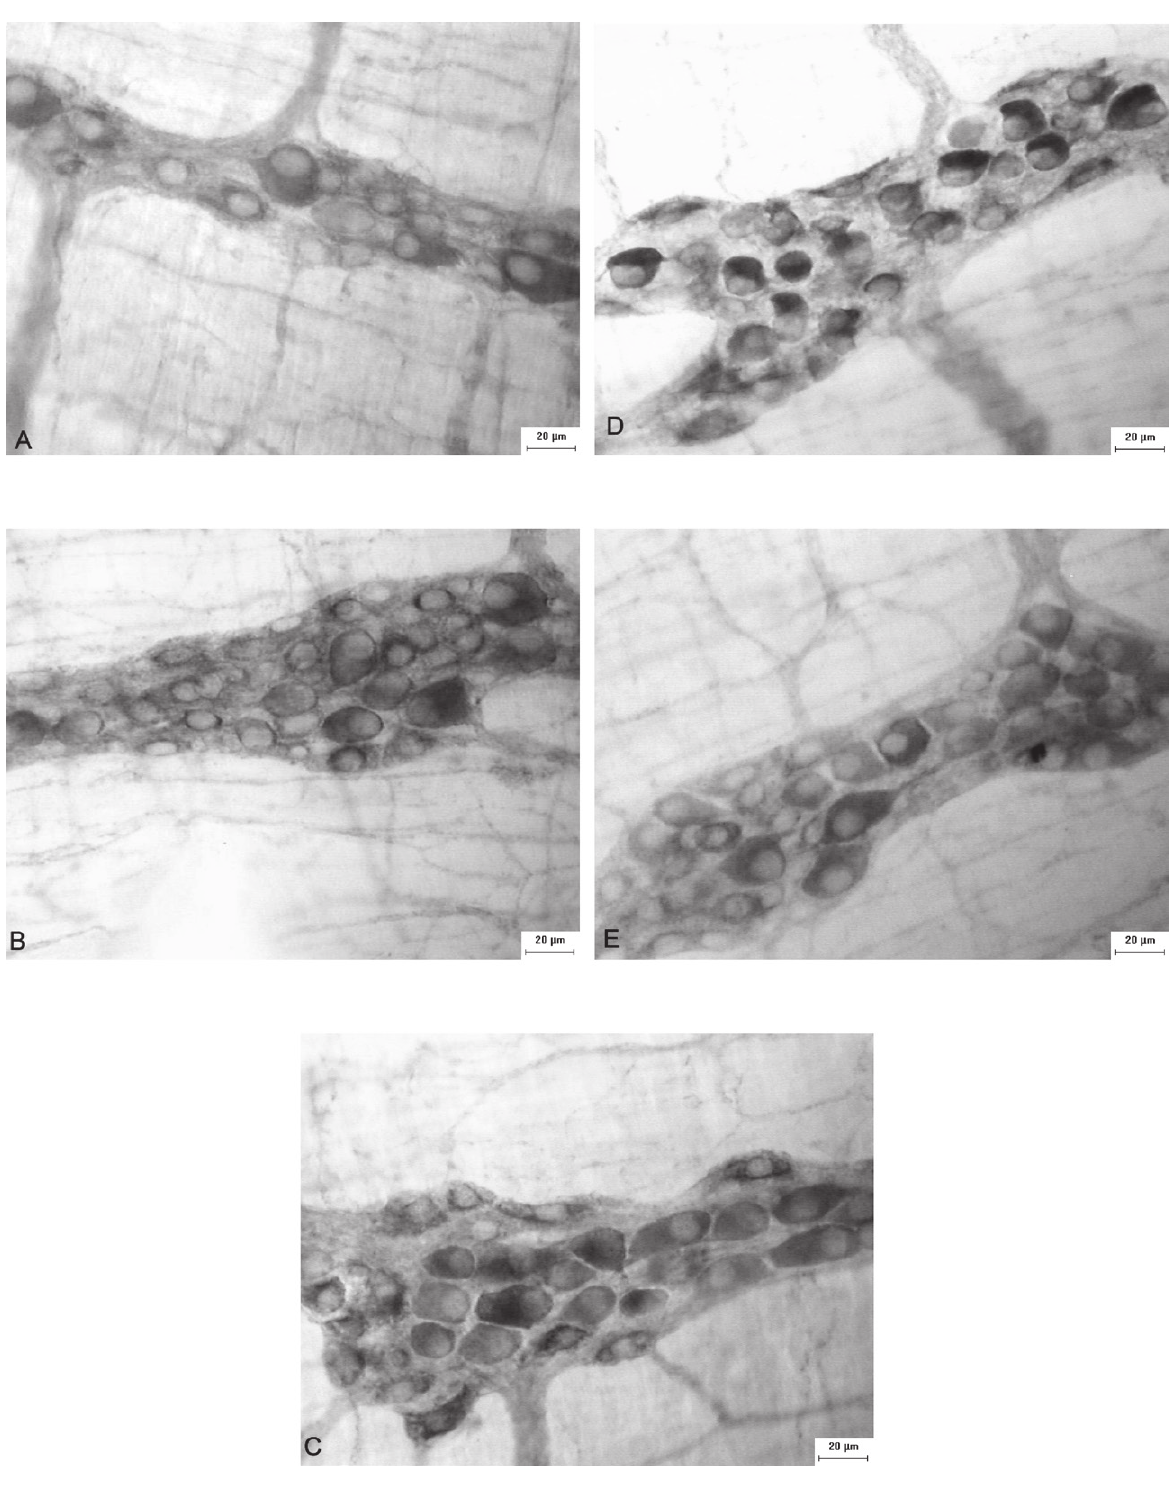
Figure 2 - Micrographs of the myenteric plexus of the ileum of rats showing myenteric ganglia stained by myosin-V belonging to animals from the groups: untreated normoglycaemic (A) , L-glutamine-treated normoglycaemic (B) , untreated diabetic (C) , L-glutamine-treated diabetic (D) , L-glutamine-treated diabetic (E) . Calibration bar: 20 μ